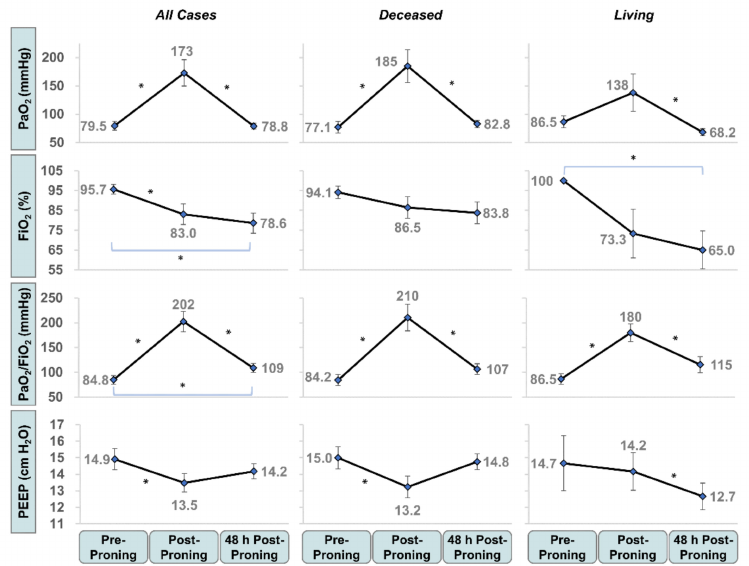
Figure 2. Change in arterial blood gas (ABG) and ventilatory parameters before, after, and 48 h after prone ventilation by living status. Mean PaO 2 , FiO 2 , PaO 2 / FiO 2 and positive end-expiratory pressure (PEEP) are presented before proning, immediately post-proning, and 48 h post-proning. Patients segmented by living status 28 d post-admission. Error bars represent S.E. of the mean. * Denotes statistical significance, given by the Wilcoxon signed-rank test with α =